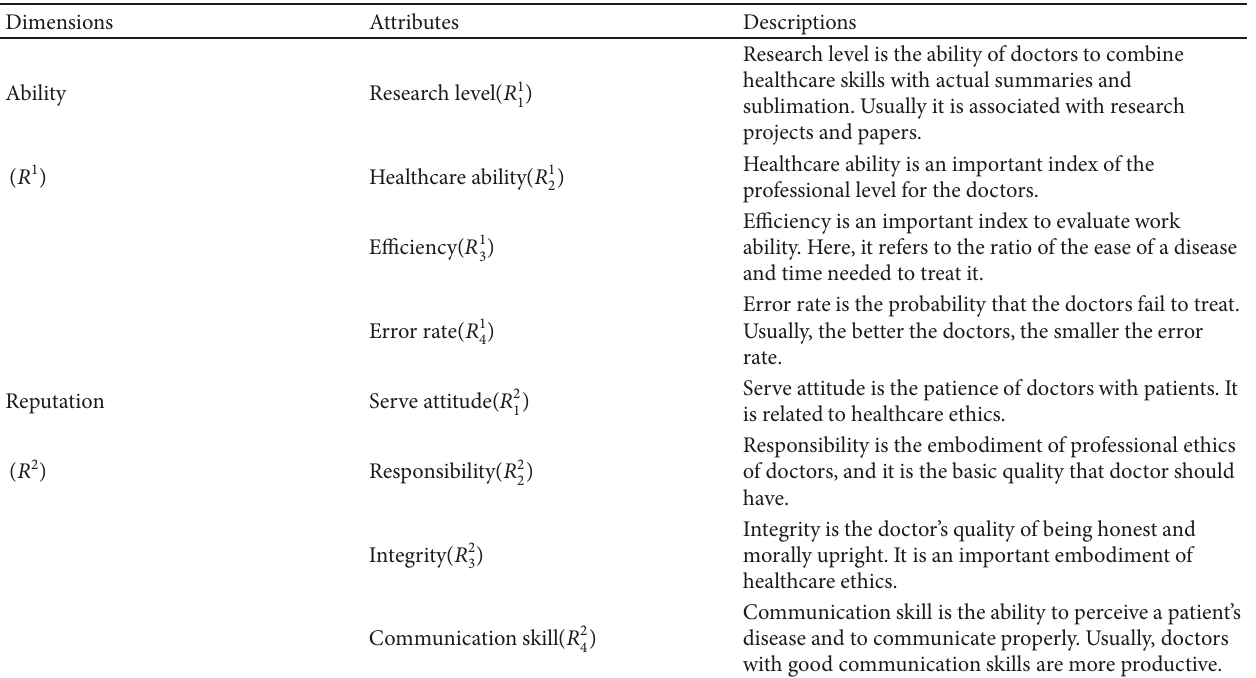
Figure 1: The framework of healthcare service quality evaluation of doctors. Table 1: Attributes for evaluating the performances on ability and